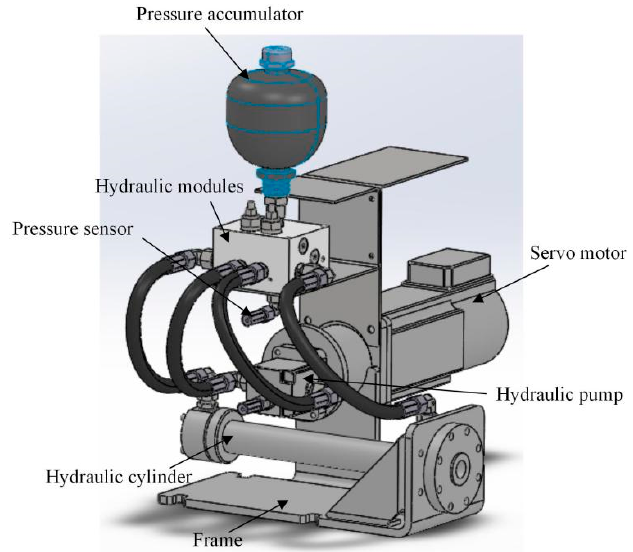
Figure 2. A servo-hydraulic cylinder with pump direct-driven system [4,5].